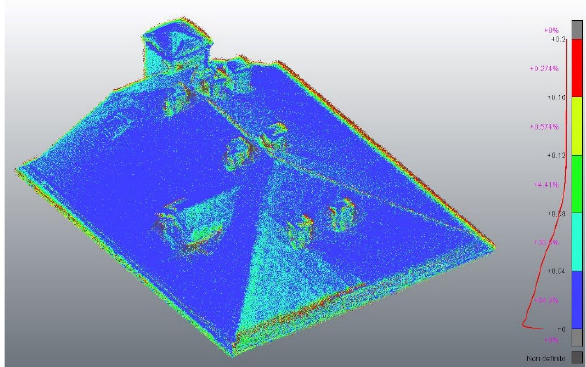
Figure 4. C2C analyses of the roof. P1 is used as ground reference and L1 as compared